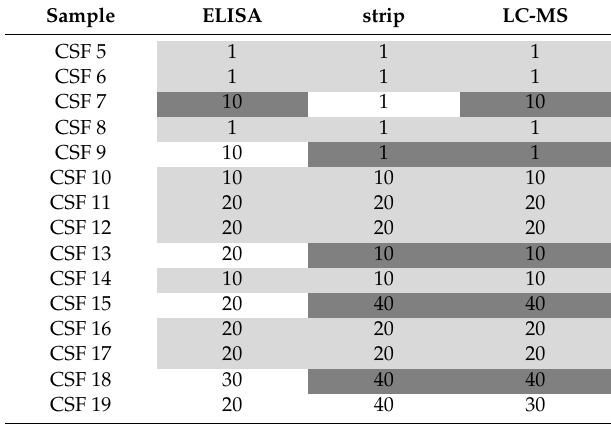
Table 3. Application of all three methods on independent dataset. Fifteen different CSF samples were analyzed with hemoglobin ELISA, Combur10-Test Strip, and LC-MS. The respective results were classified to the defined contamination levels as listed in Table 2. Samples that were assigned by all three approaches to the same blood level are highlighted in light gray, and samples that were assigned to the same level by two approaches are marked in dark gray.